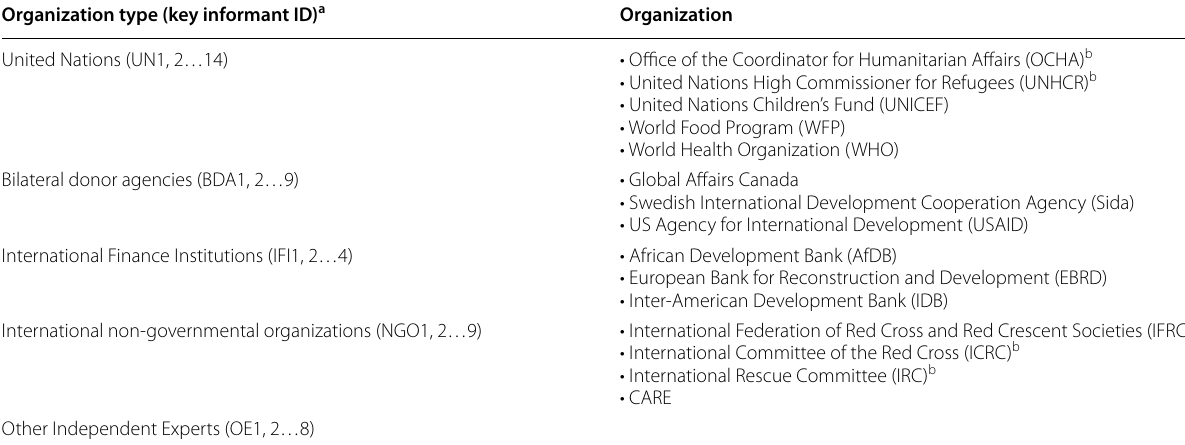
a To ensure confidentiality, key informants were assigned a serial number within each category of type of organization. In the text below, we use the assigned serial number to cite the key informants b Organizations that only provide humanitarian